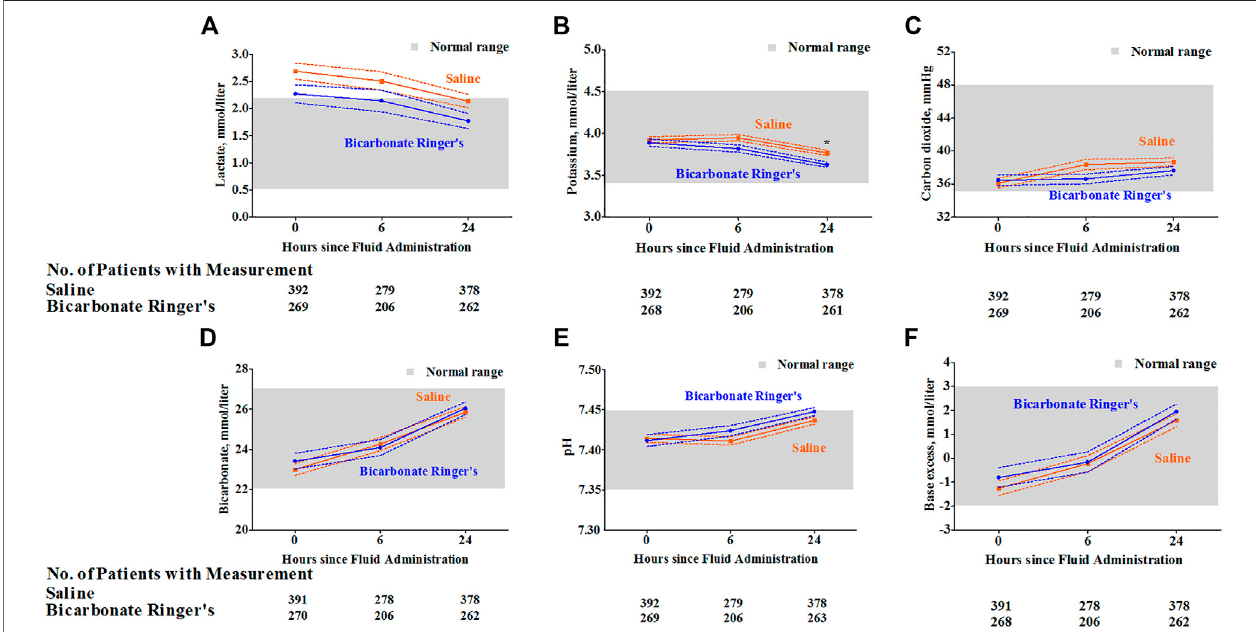
FIGURE 3 | Change of arterial blood gas analysis of each group after the fl uid administration. The mean and standard error of arterial blood gas analysis including lactate (A) , potassium (B) , partialpressure ofcarbon dioxide (C) , plasma concentration ofbicarbonate (D) ,pH level (E) and base excess (F) after the fl uid administration were shown for patients in each group. The partial pressure of carbon dioxide [F time (2, 1780) = 5.02; p = 0.0067], pH level [F time (2, 1781) = 14.88; p < 0.0001], base excess [F time (2, 1777) = 35.25; p < 0.0001], plasma concentration of bicarbonate [F time (2, 1779) = 34.61; p < 0.0001], potassium [F time (2, 1778) = 18.05; p < 0.0001] and lactate[F time (2, 1778) = 5.77; p = 0.0032] were changed over time. Differences between bicarbonate Ringer ’ s group and saline group were only observed on lactate[F fl uidtype (1,1780)=8.75; p =0.0031]and potassium [F fl uidtype (1,1778) =10.57; p =0.0012]. Bonferroni ’ spost hoctestwasperformed foreachtime point, respectively, and the signi fi cance was highlighted by asterisk (* stands for p <